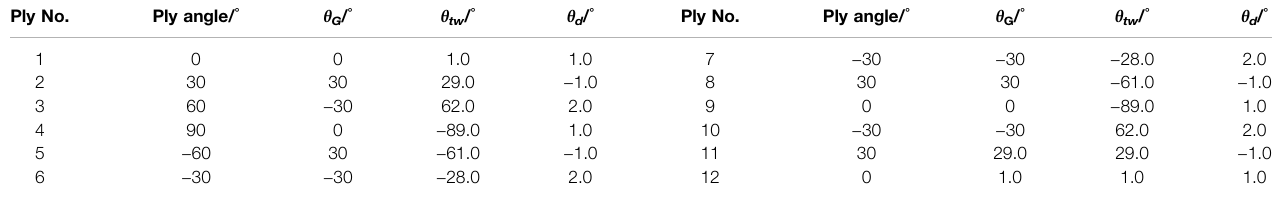
TABLE 5 | De fl ection angles of Stacking No. 2 with unit ply angle misalignment in each layer at one time. Ply No.